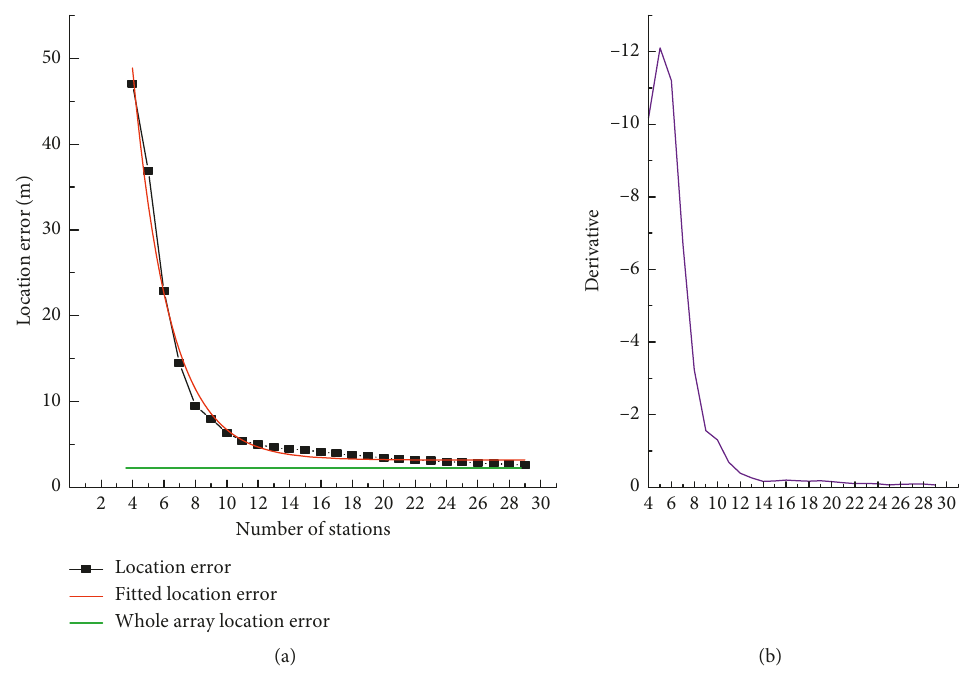
Figure 12: Relationship between the location error and the number of